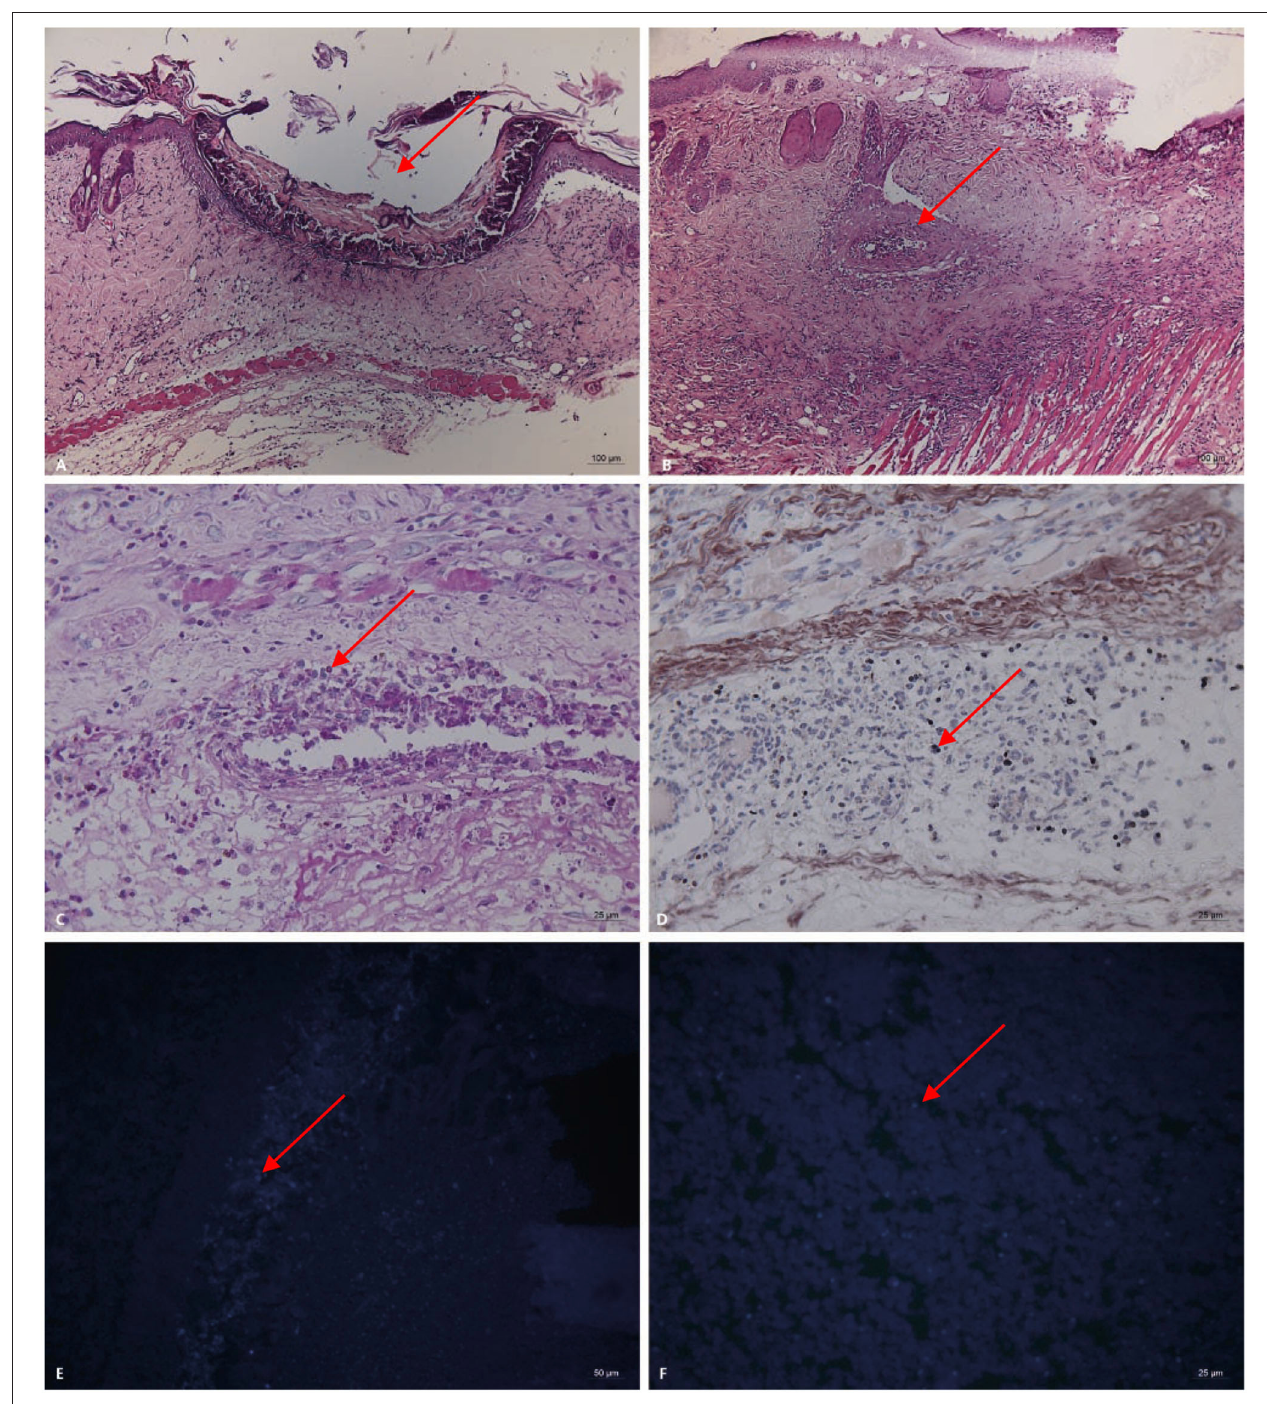
FIGURE 3 | Pathogenicity in the mouse models of Trichoderma longibrachiatum (PKUT180420015) from pulmonary spindle cell carcinoma ( A–F : 14 days after inoculation in Group 3). (A) Ulcer formation (arrow) and inflammatory cells increase and accumulate (HE). (B) Vasculitis (arrow) around the ulcer (HE). (C) Fungal spores (arrow) in and around the blood vessels, and the blood vessel wall is red and necrotic (periodic acid-Schiff staining, original magnification × 400). (D) Fungal spores (arrow) in the vascular lumen and vascular wall (periodic acid-silver methenamine). Panel (E,F) shows fungal spores (arrow) at the inoculation site and necrotic tissue (Calcofluor